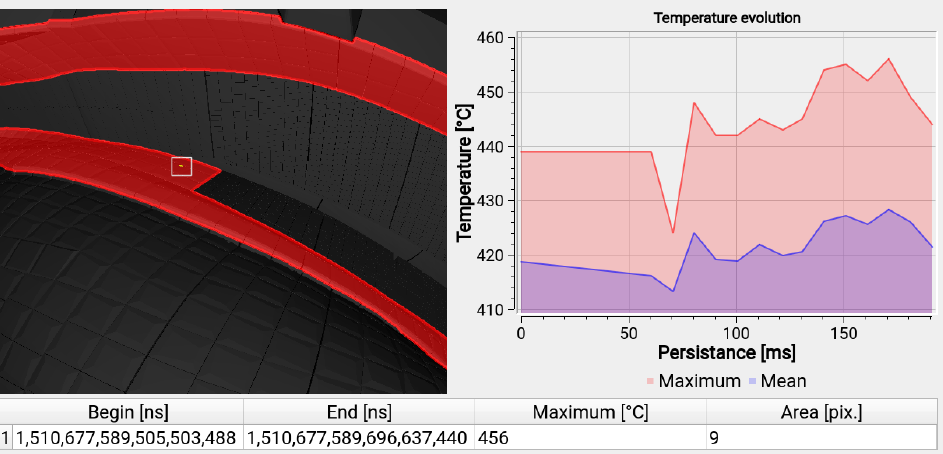
Figure 7. The detected and tracked hotspot. The results are summarised with the application developed to manage and monitor the processing